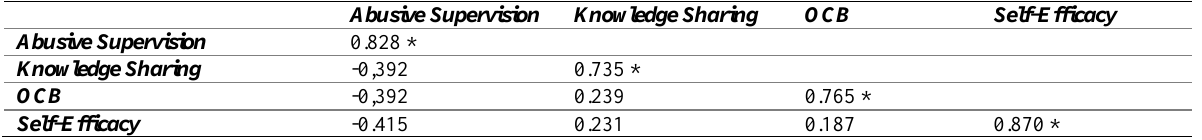
Table 3: Discriminant